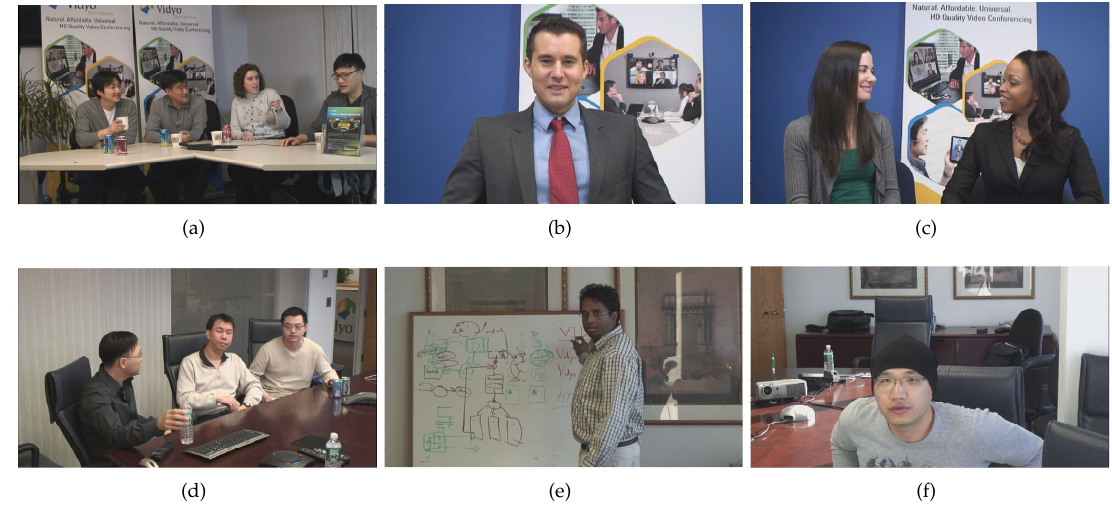
Figure 5. The test sequences. ( a ) FourPeople; ( b ) Johnny; ( c ) KristenAndSara; ( d ) Vidyo1; ( e ) Vidyo3; ( f )